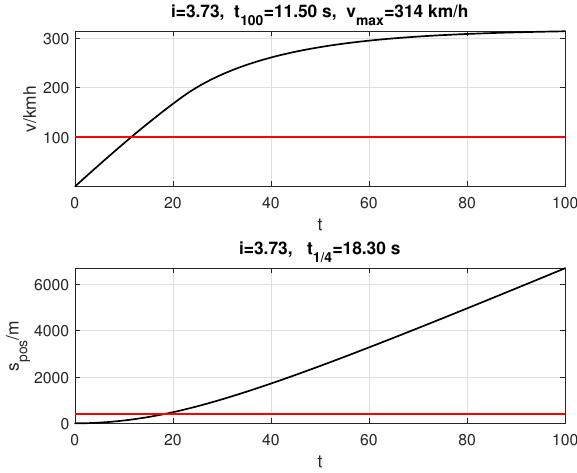
Figure 10. Optimized gear ratio i of EV for J = − v max